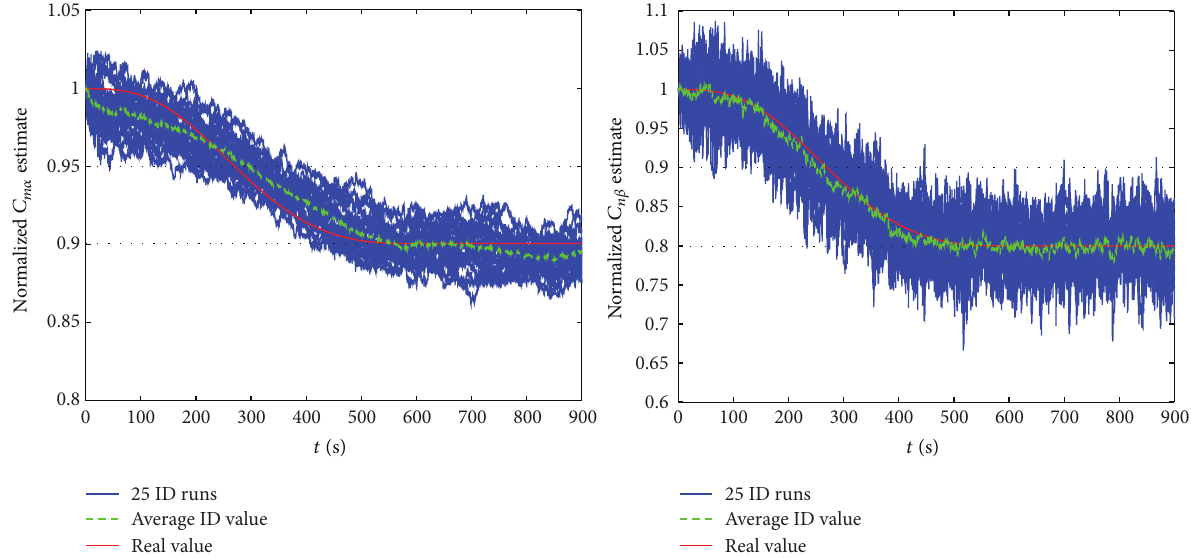
Figure 4: ID results for moderate icing